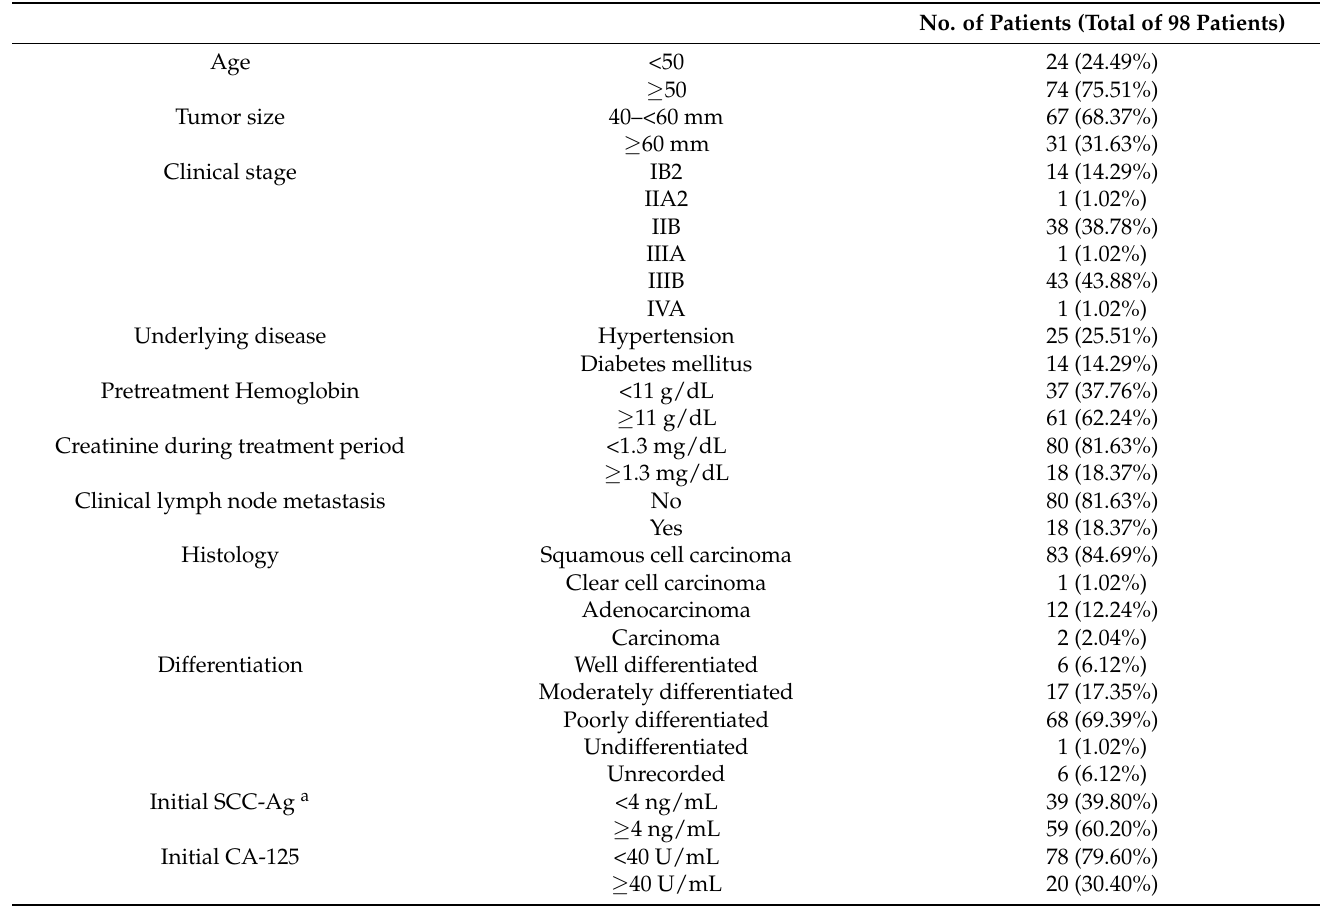
Table 1. Patient demographic features and characteristics.